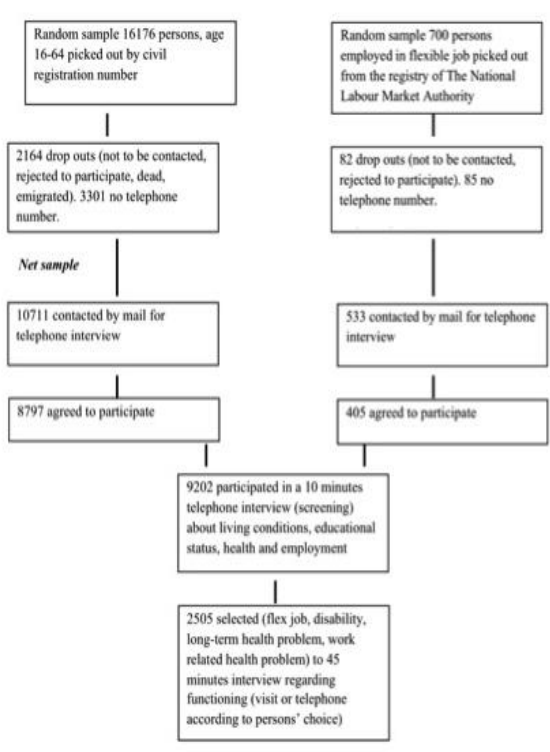
Figure 1 Sample selection